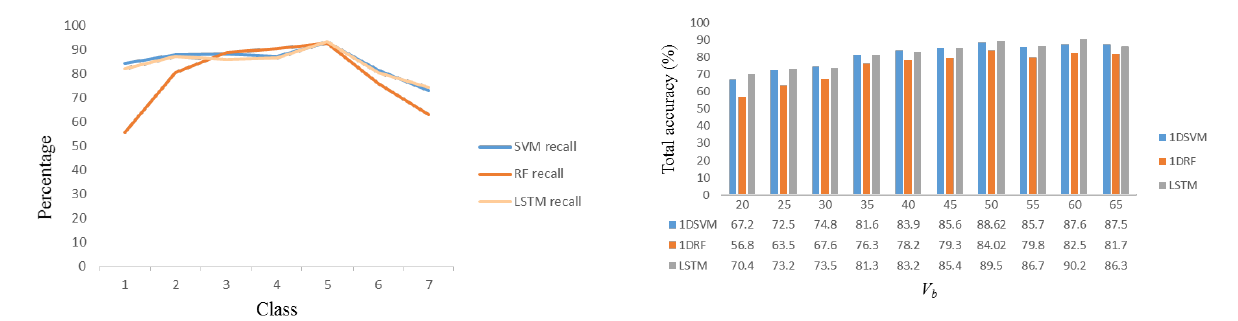
Figure 6: Precision values of different classes for June month of Stuttgart.